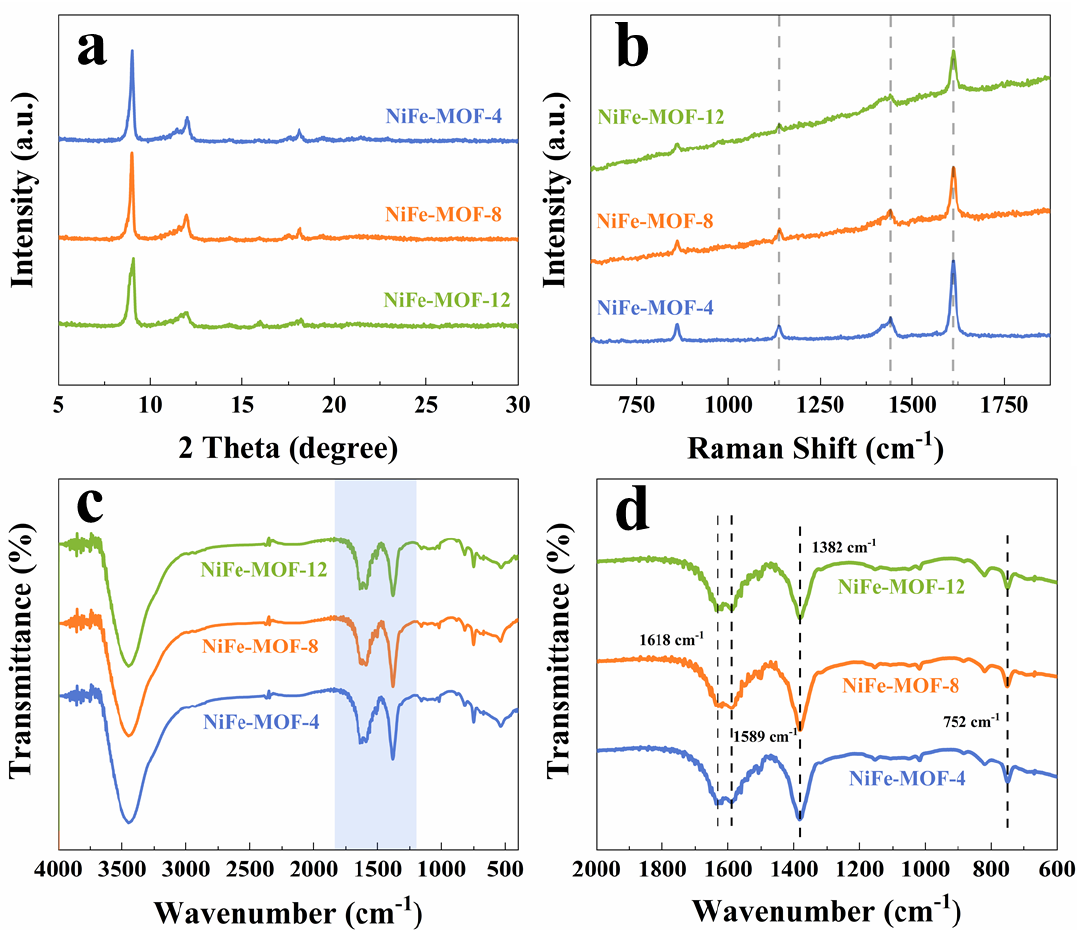
Figure 3. Structure and composition of the samples: ( a ) XRD patterns, ( b ) Raman spectrum, ( c ) FT−IR spectrum, ( d ) 600~2000 cm −1 enlarged FT−IR spectrum.